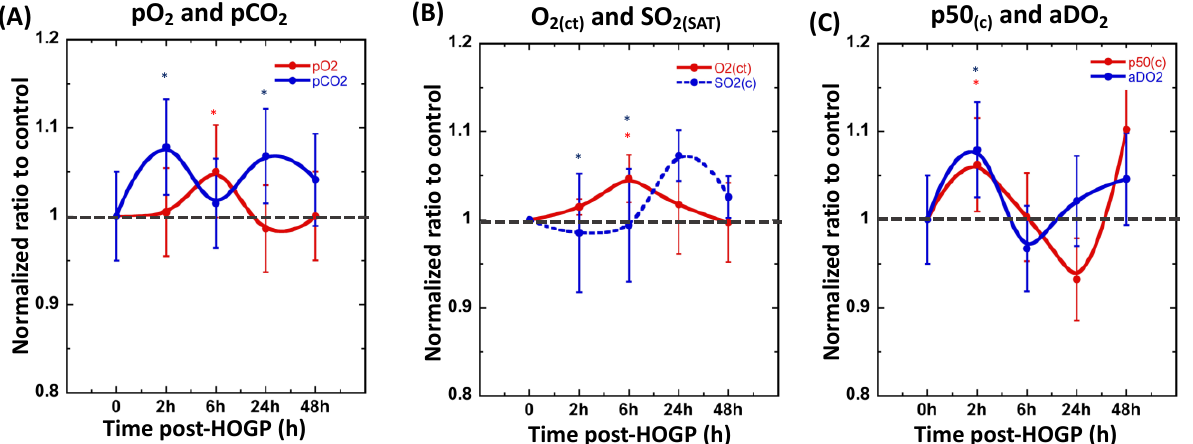
Figure 5. Time course of biological parameters post-application of the HOGP. Normalized ratios of pO 2 and pCO 2 ( A ), O 2 and SO 2 ( B ), and p50 (c) and aDO 2 ( C ). The normalized ratios ( y -axis) were determined by normalization to the control group. Significant differences were identified using t -tests (* p < 0.05).